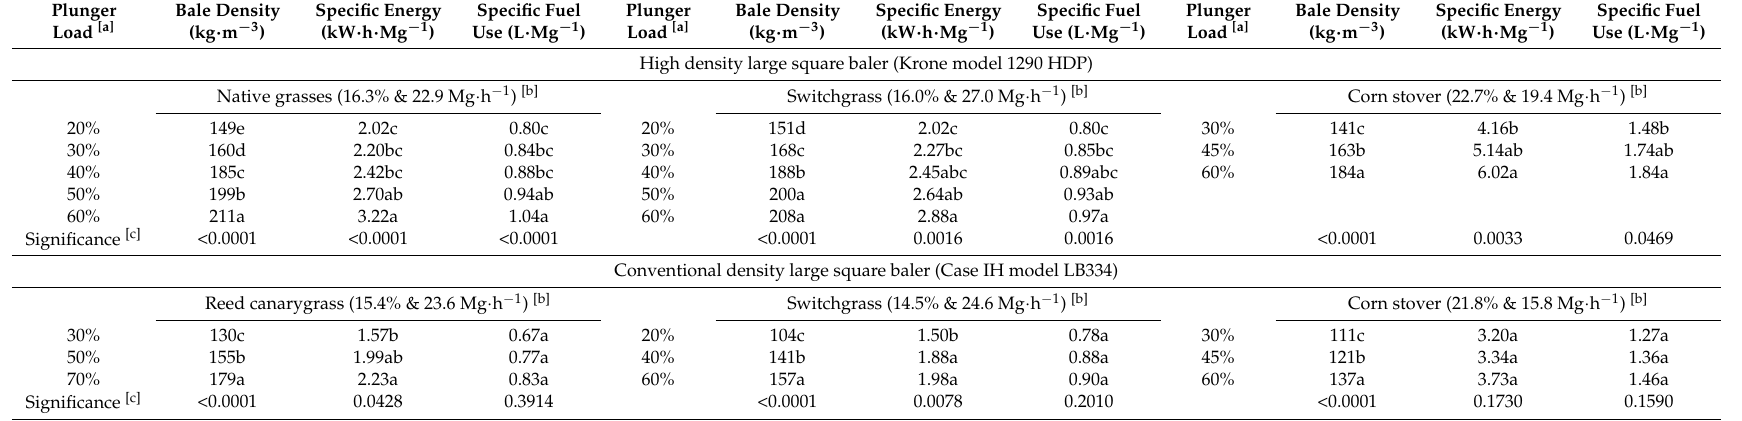
Table 3. Large square bale density and specific energy and fuel use (all on a dry basis) as affected by plunger load and baler type (LSBr expr. No. 2, Table 1). Plunger Load